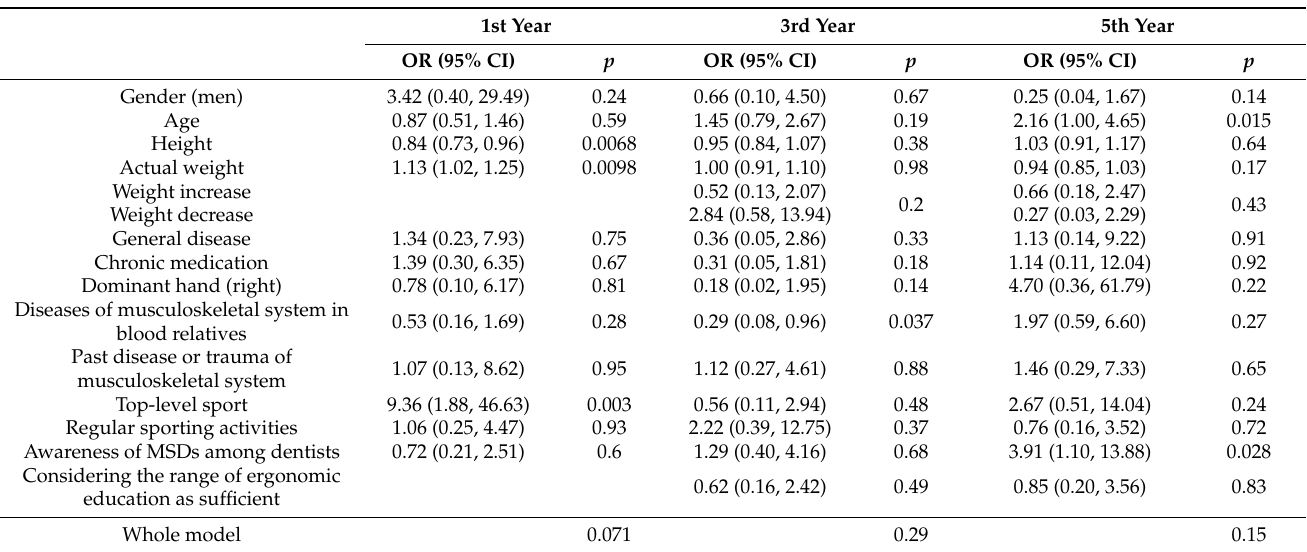
OR, odds ratio; CI, confidence interval. Table 5. The multivariate analysis of the influence of the followed factors on the occurrence of lower back